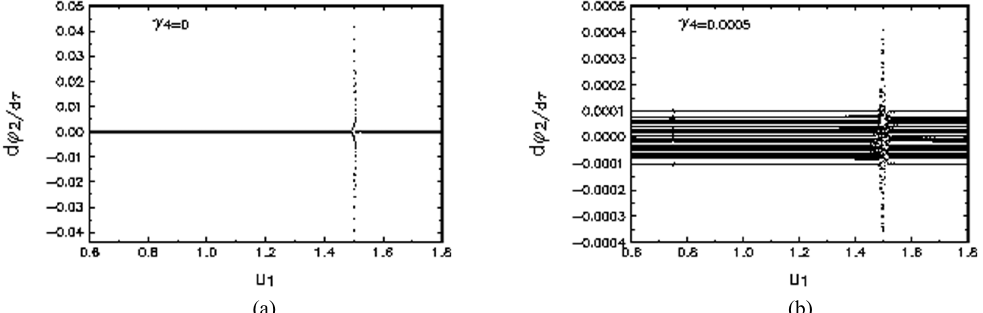
Fig. 7. Bifurcation diagrams of ϕ 2 for γ 4 = 0 (a) and γ 4 = 0.0005 (b) and for: a 1 = a 2 = 0.1; a 3 = 0.0001; γ 1 = 0.0001; γ 2 = γ 3 = 0; β 1 = 0.65; c = 1; u 2 = 1.5; q =